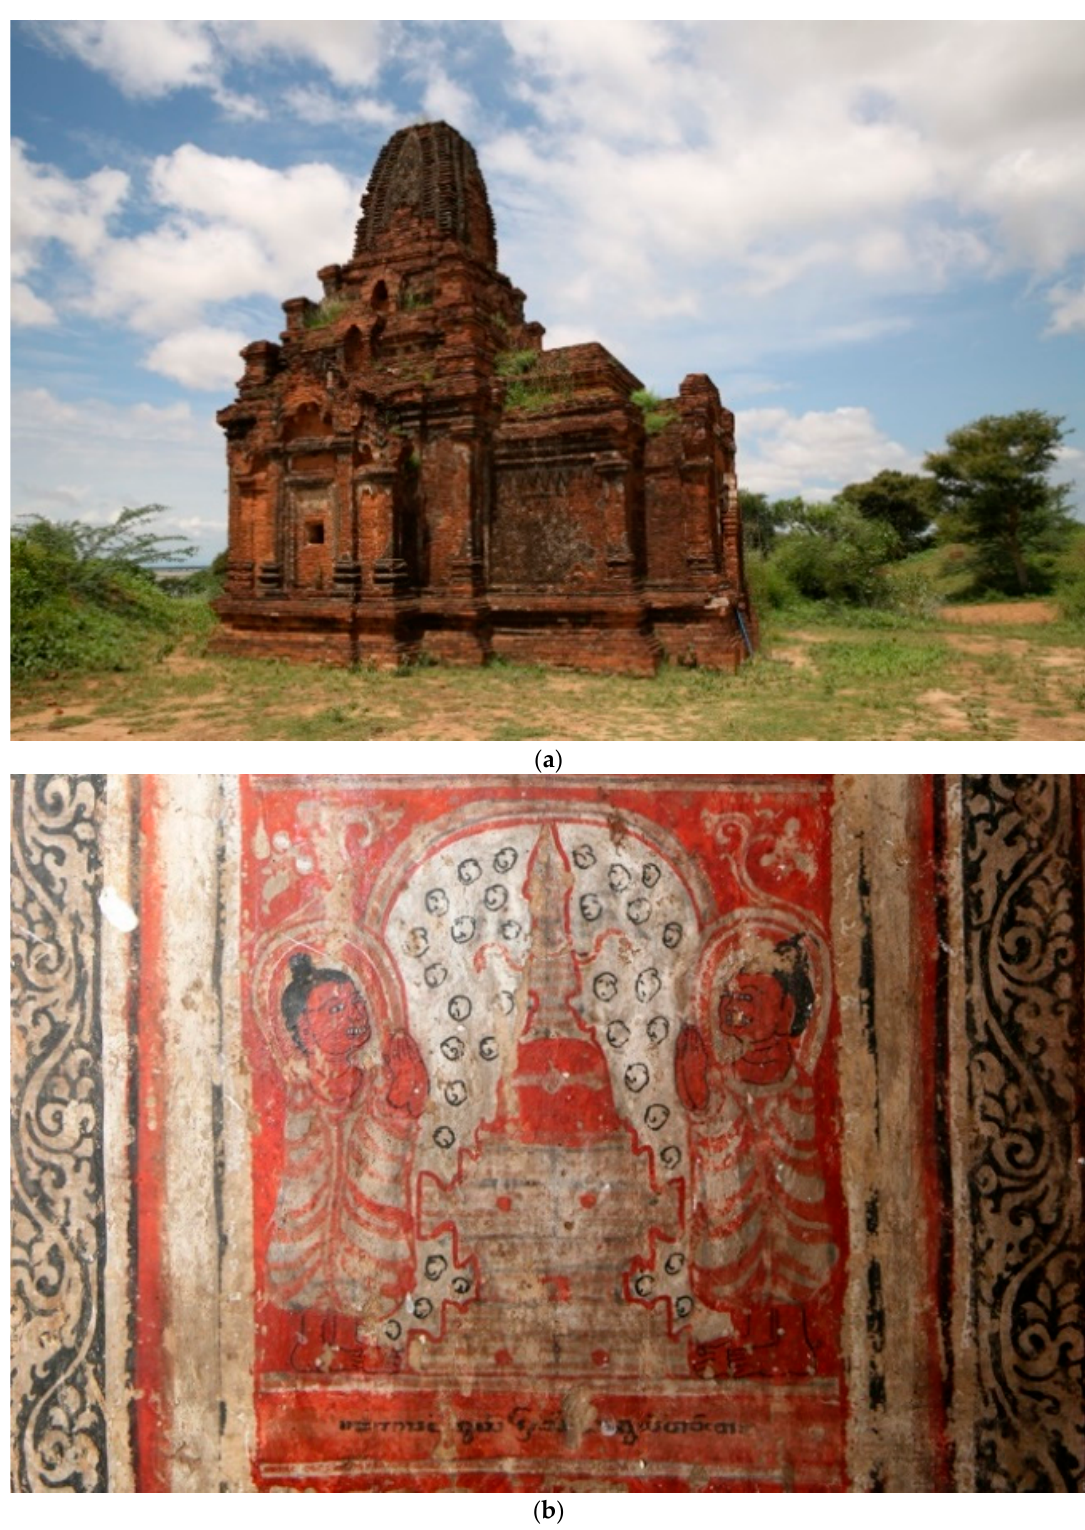
Figure 25. ( a ) Hsale 13th century, Endowment 13. On the periphery of the capital, numerous structures materialize by the 13th century, in satellite towns like Sale, and Hsale. This one has a well-preserved décor. ( b ) Hsale, 13th century, endowment 13. Two Chinese worshippers in their typical 13th century attire (as Pagan’s painters assumed) revering the tooth relic.